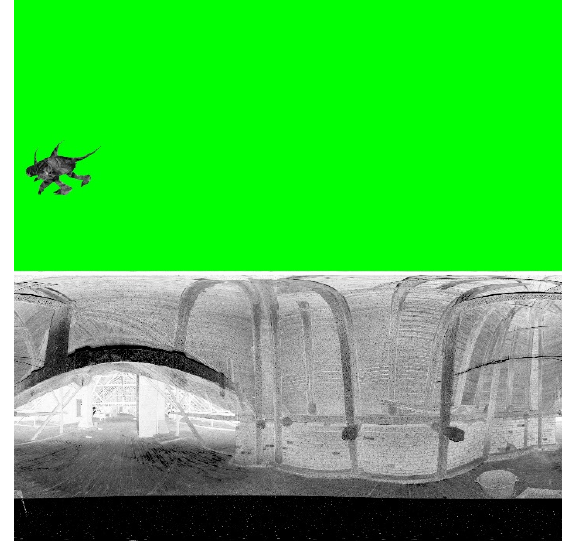
Figure 6. Top, single photogram of the animation (after stitching); Bottom, left spherical image representing the environment Specifically, for managing this large number of frames, we have developed a script that allows to rename and organize the spherical frames, specifically for complying the input data demands in the stitching processing using Stitch Sequence of Grid of Image (Figure 7).